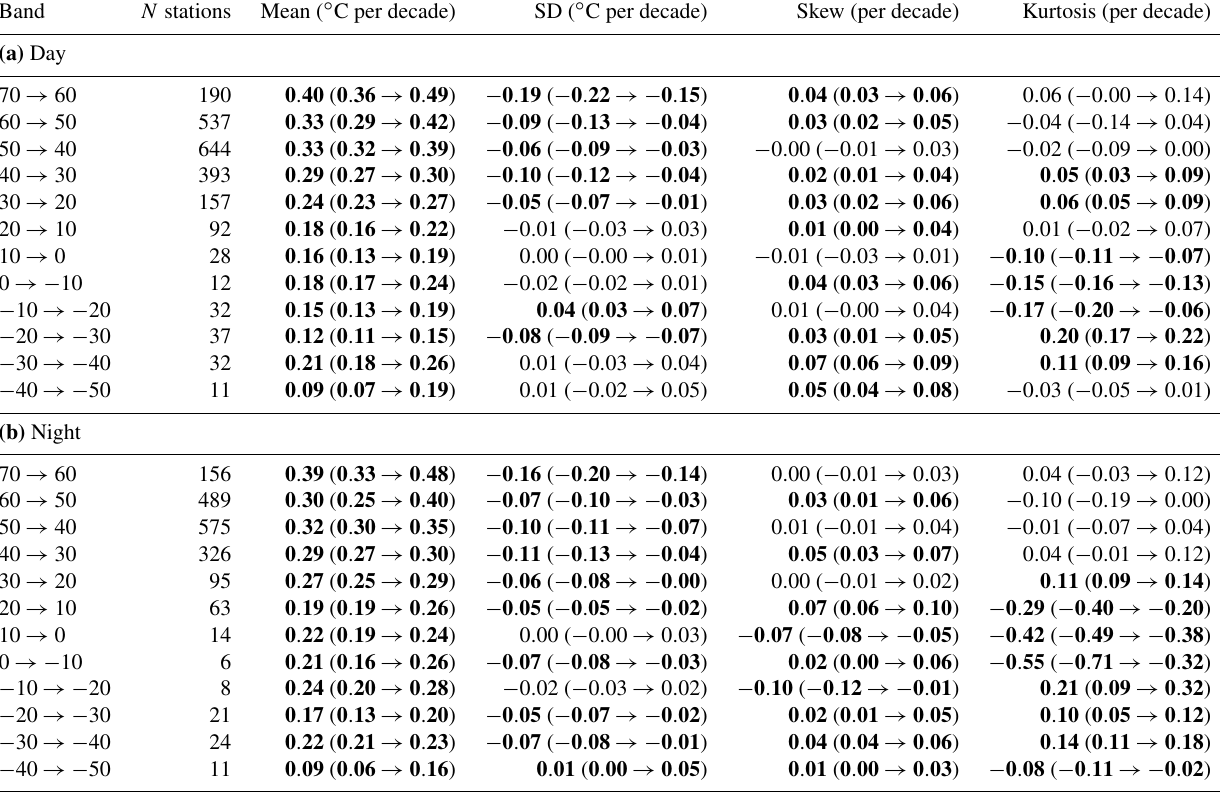
Table 1. Linear change per decade in fits to parameters in zonal analysis for (a) daytime and (b) night-time temperature observations over 1974–2018. Values in bold show parameters and bands for which the 1 σ range of the fitted trend does not include